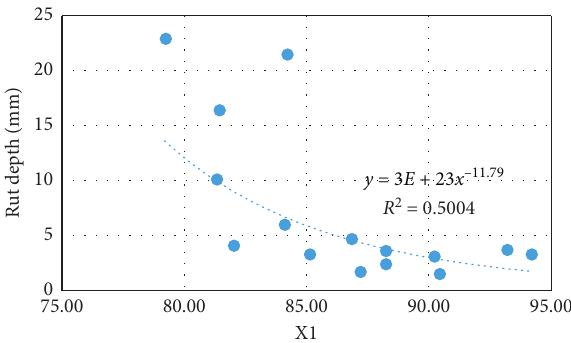
Figure 4: Correlation between X1 and rut depth ( n � 15).